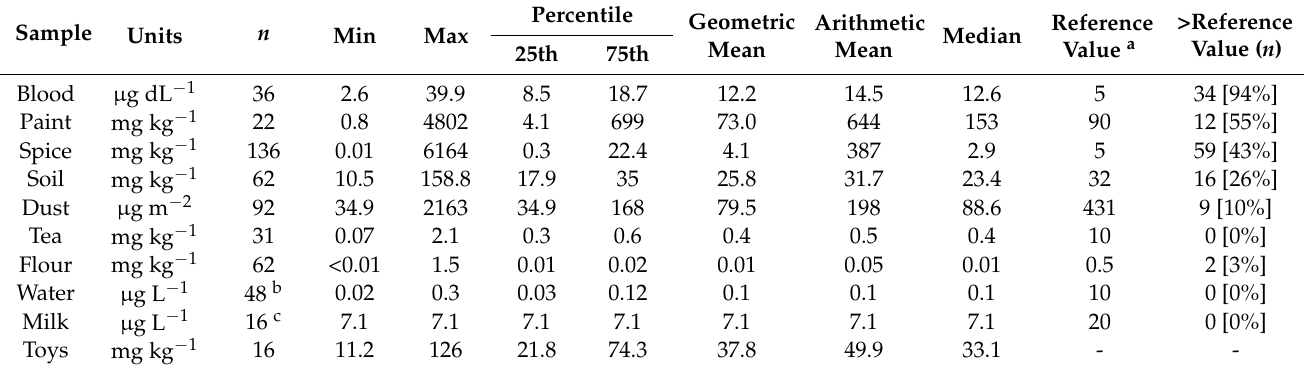
Table 2. Summary of Pb concentration data as determined for each sample type.